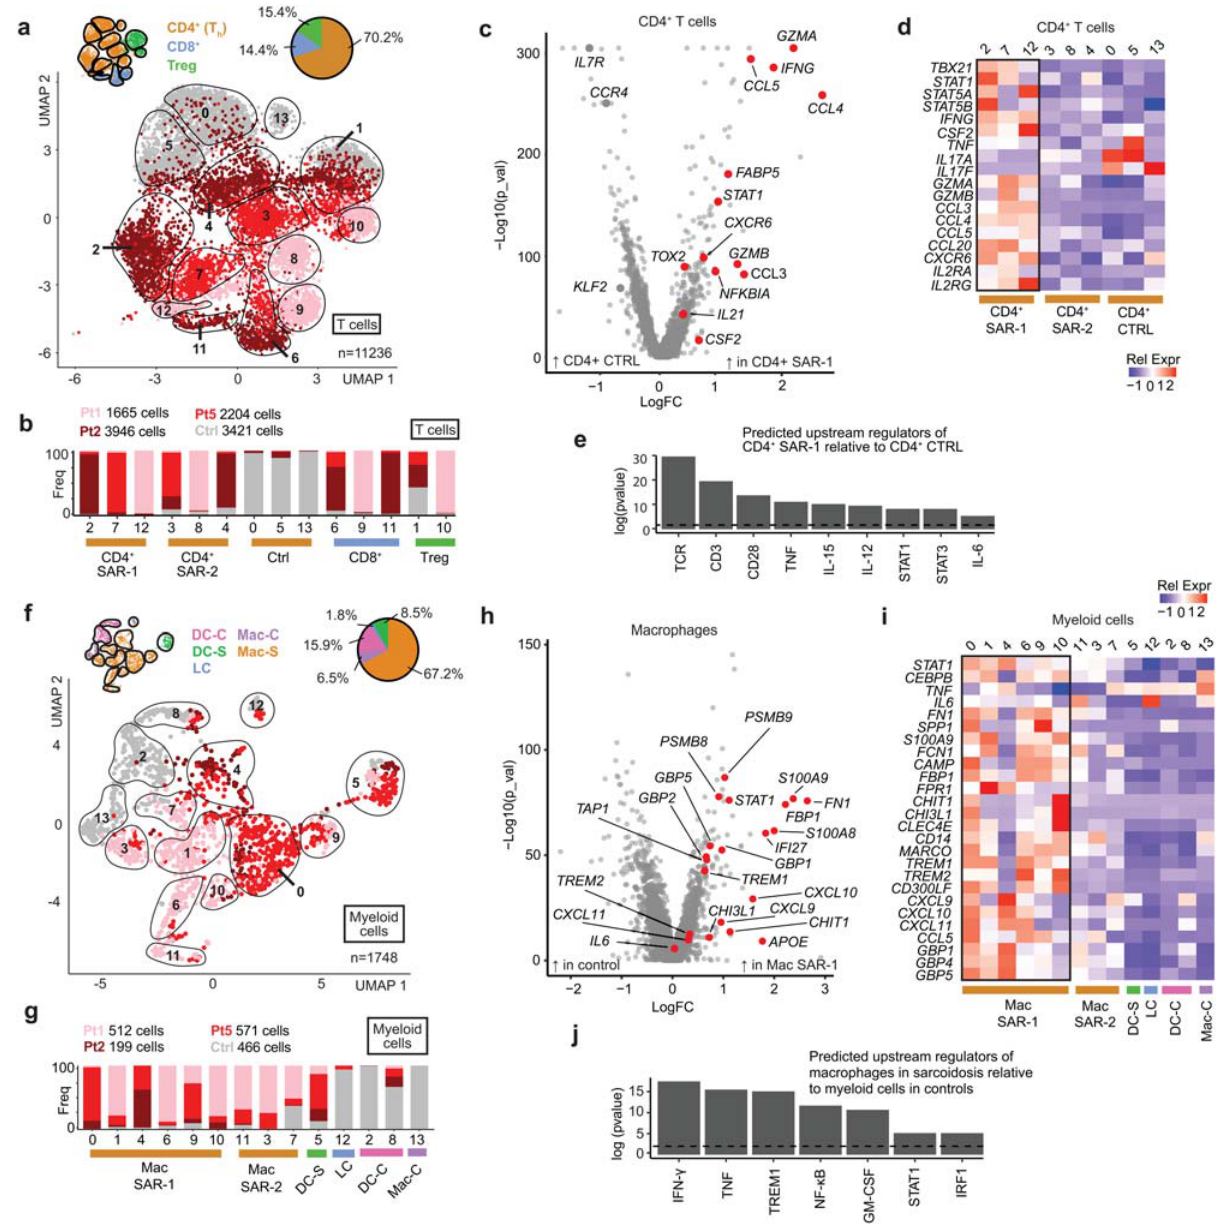
Fig. 4 IFN- γ produced by Th1 polarized CD4 + T cells activates macrophages in cutaneous sarcoidosis. a UMAP projection of scRNA-seq data showing T cell clusters in sarcoidosis (shades of red) compared to healthy controls (grey). b Histograms showing contribution of each condition (sarcoidosis: shades of red, grey: controls) to each T cell cluster. c Volcano plot showing the most differentially expressed genes between CD4 + SAR-1 (clusters 2,7,12) versus CD4 + CTRL (clusters 0,5), corresponding to Fig. 4a. p value determined using Wilcon Rank-Sum test, two-tailed. d Heatmap showing expression of selected transcripts in CD4 + FOXP3 - T cell clusters. e Histogram showing selected predicted upstream regulators of CD4 + SAR-1 clusters (2,7,12) versus CD4 + CTRL clusters (0, 5) as determined by IPA. Signi fi cance cutoff of p < 0.001 is shown by a dotted horizontal line and determined using Fisher exact test, right-tailed. f UMAP projection of scRNA-seq data showing myeloid cell clusters in sarcoidosis (shades of red) compared to healthy controls (grey). g Histograms showing contribution of each condition (sarcoidosis: shades of red, grey: controls) to each myeloid cluster. h Volcano plot showing the most differentially expressed genes between Mac SAR-1 (clusters 0,1,4,6,9,10) versus control myeloid (clusters 2,8,13). p value determined using Wilcon Rank- Sum test, two-tailed. i Heatmap showing expression of selected transcripts in myeloid clusters. j Histogram showing selected predicted upstream regulators in Mac SAR-1 and Mac SAR-2 (clusters 0,1,3,4,6,7,9,10,11) versus myeloid cells in controls (clusters 2,8,13) as determined by IPA. Signi fi cance cutoff of p < 0.001 is shown by a dotted horizontal line, as determined using Fisher exact test, IFN- γ -activation is conserved across sarcoidosis . Together, data from bronchoalveolar lavage (BAL) fl uid from 4 patients with sarcoidosis 29 and compared to 10 healthy control patients 30 . these data strongly implicated IFN- γ derived from an aberrant Of 55,908 total cells, 4,621 were T cells (Fig. 5a – e). Although T h 1 response as a key driver of sarcoidosis in skin. Next, we recovery of T cells in the sarcoidosis samples appeared sub- evaluated whether a similar population of CD4 + T cells could also optimal, we observed that similarly to the skin, in BAL the be identi fi ed in pulmonary sarcoidosis. We analyzed scRNAseq